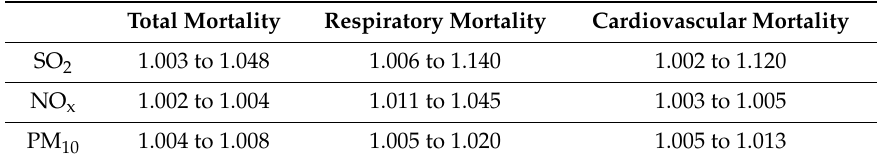
Table 9. RR values (95% CI) for each 10 µ g / m 3 increase in the daily mean concentration of each pollutant [60].